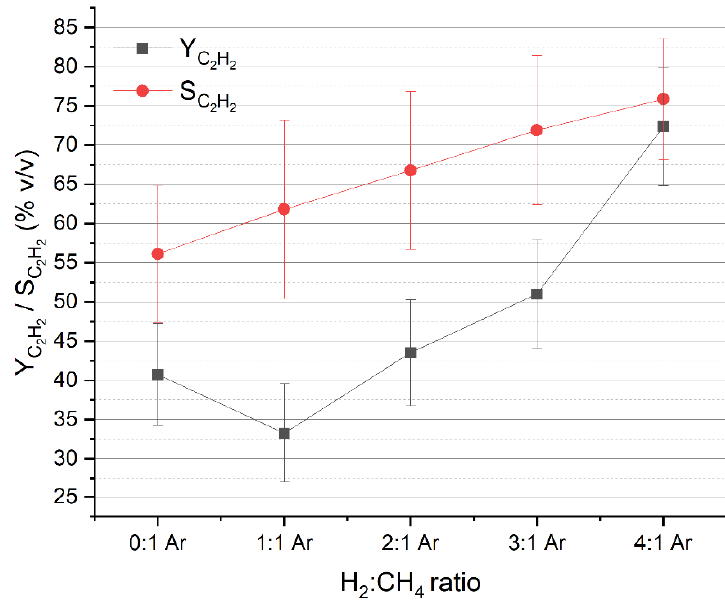
Figure 2. H 2 impact on C 2 H 2 selectivity and yield.